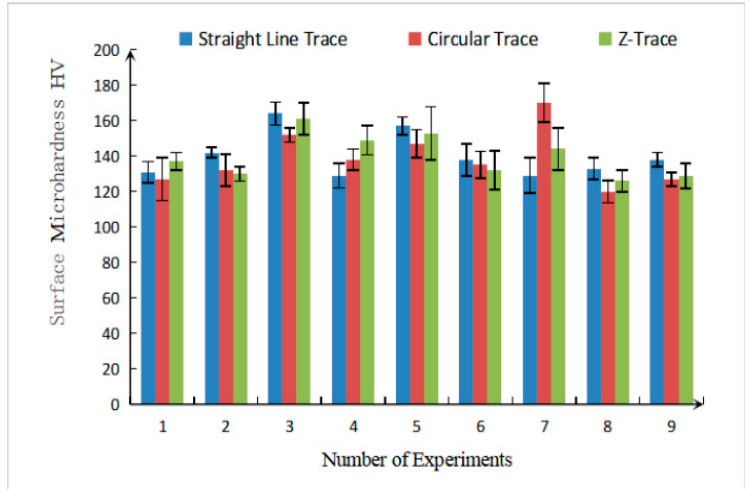
Figure 21. Surface micro-hardness of the three different grinding tracks.